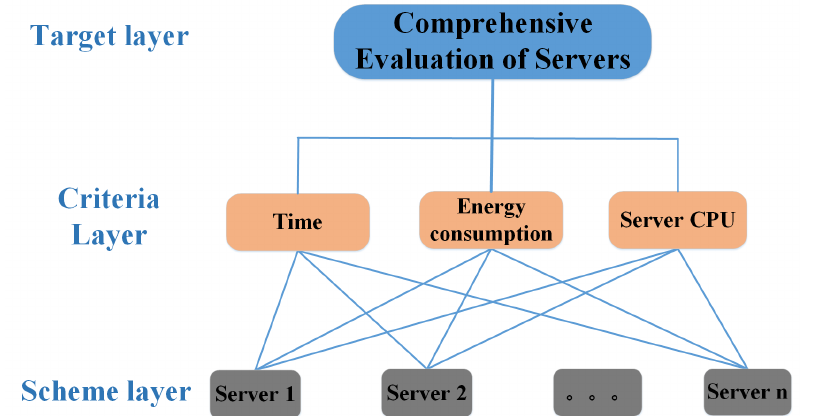
Figure 1. AHP Hierarchy model for choosing a suitable server. The hierarchical model consisted of three layers: the target layer, criterion layer, and scheme layer. The target layer is the final conclusion of the model as the comprehensive evaluation of servers that meet the requirements of computation offloading. The criteria layer is the factor that is relied on when evaluating the servers. The scheme layer is a server that can be used for the computation offloading, and a server represents a solution.